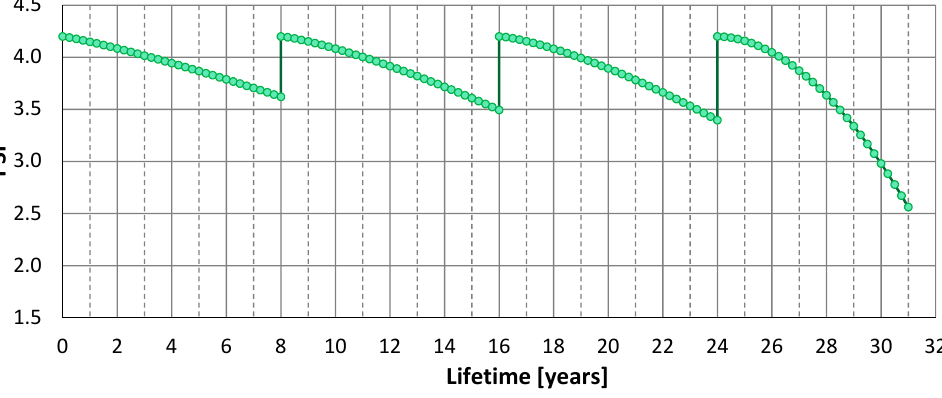
Figure 2. PSI variation of O WR –O DR scenarios.